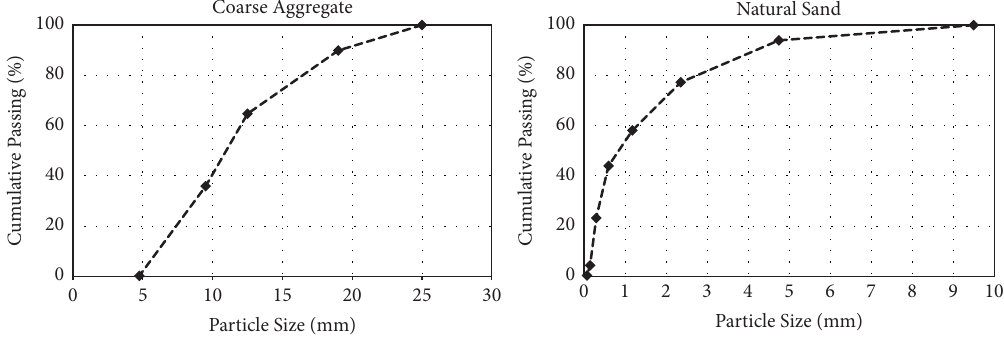
Figure 2: Particle size distribution curves of aggregates. Table 2: Proportions of the concrete mixtures.